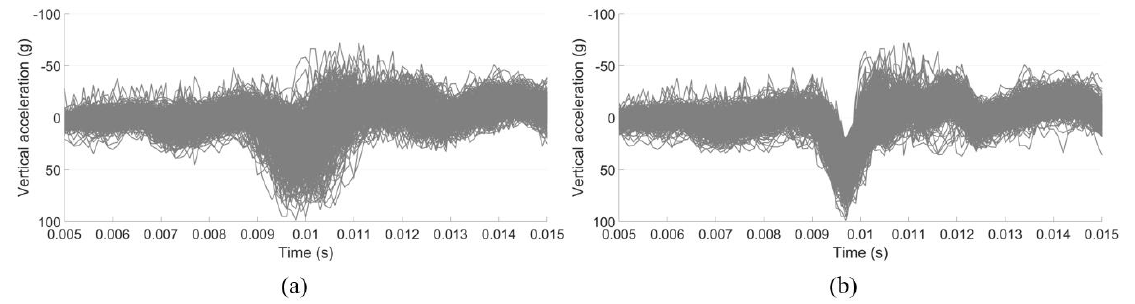
Figure 15. Measured acceleration responses: ( a ) original time − domain results and ( b ) modified results, with the time histories aligned horizontally with the impact point.